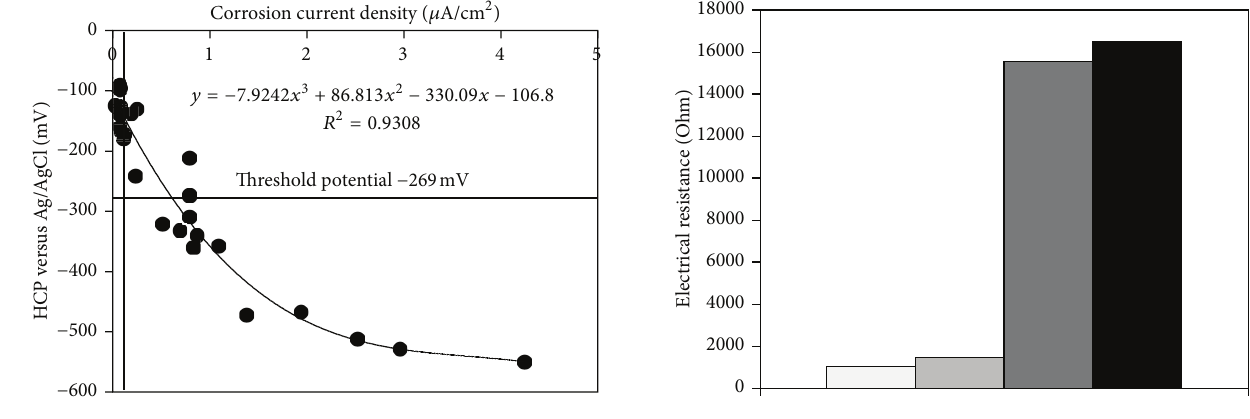
Figure 8: Corrosion current density versus HCP.